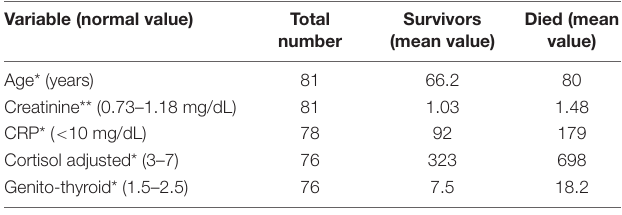
TABLE 1 | ANOVA of admission variables.